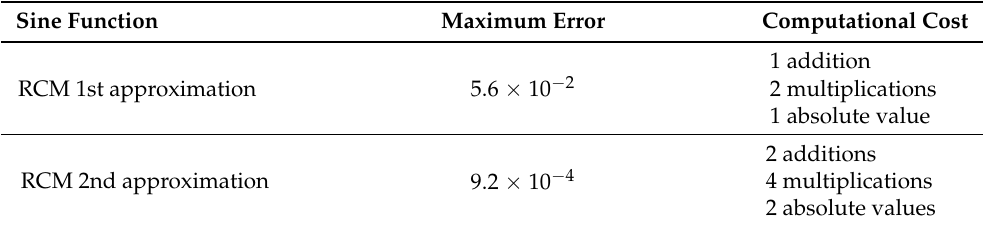
Table 3. Error and computational cost of approximating trigonometric functions. Sine Function Maximum Error